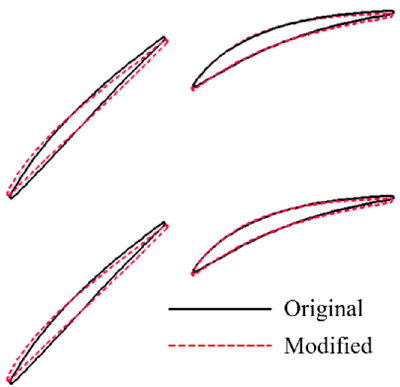
Figure 16. Comparison of blade geometry.